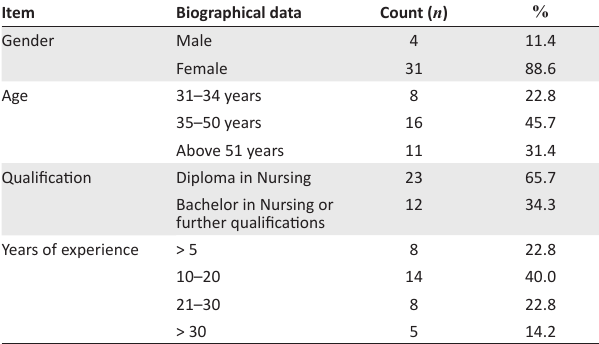
Table 2 outlines the identified themes and sub-themes. TABLE 1: Characteristics of